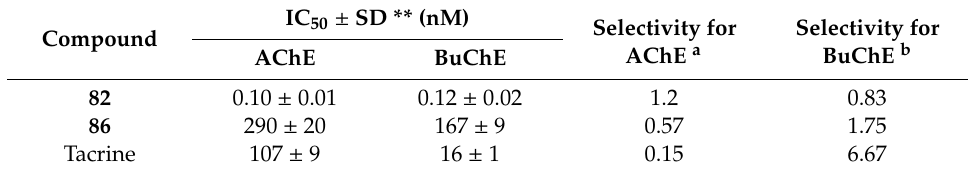
Table 4. The activity of 82 and 86 against two cholinesterases.